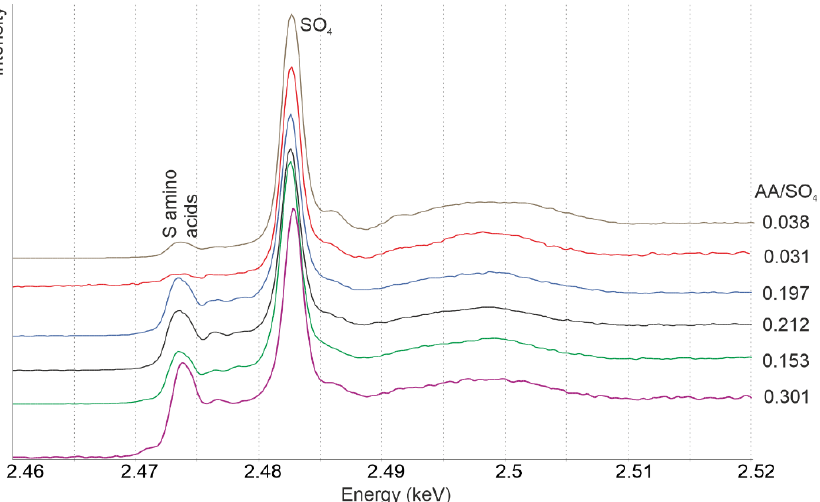
Figure 10. Micro ‐ XANES spectra at the S K edge showing the presence of two categories of pearl layer deposits: one is rich in sulfur amino acids, another one poor in these amino acids.